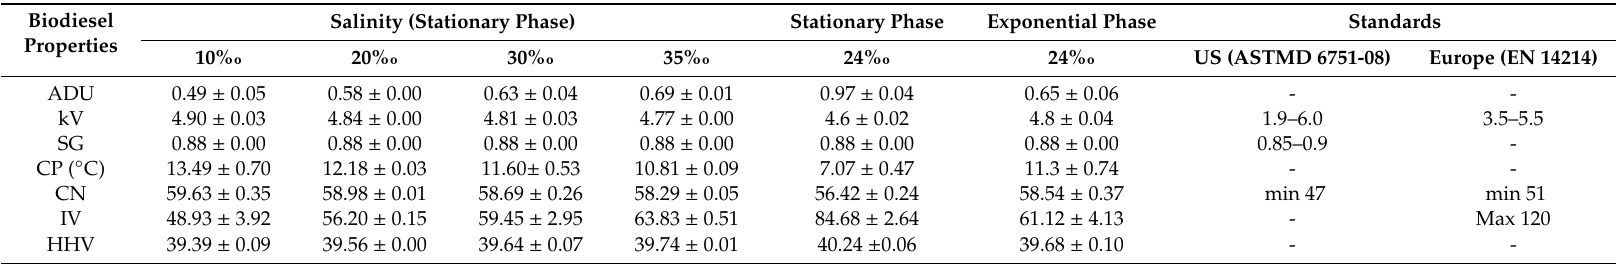
Table 6. Biodiesel properties of N. salina nl6 in di ff erent salinities and growth phases.